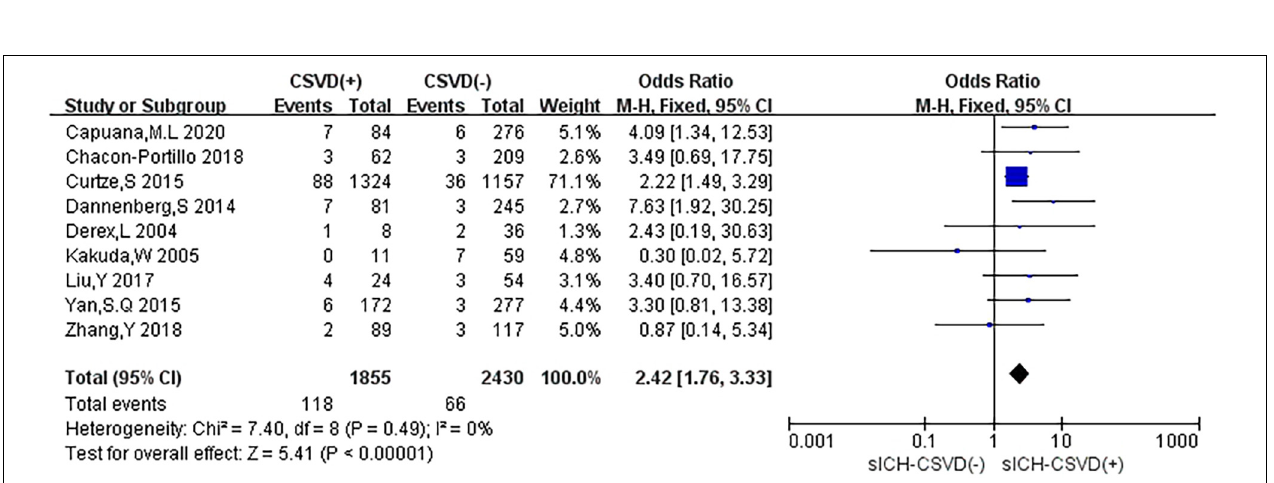
FIGURE 5 | Forest plot showing the impact of CSVD on